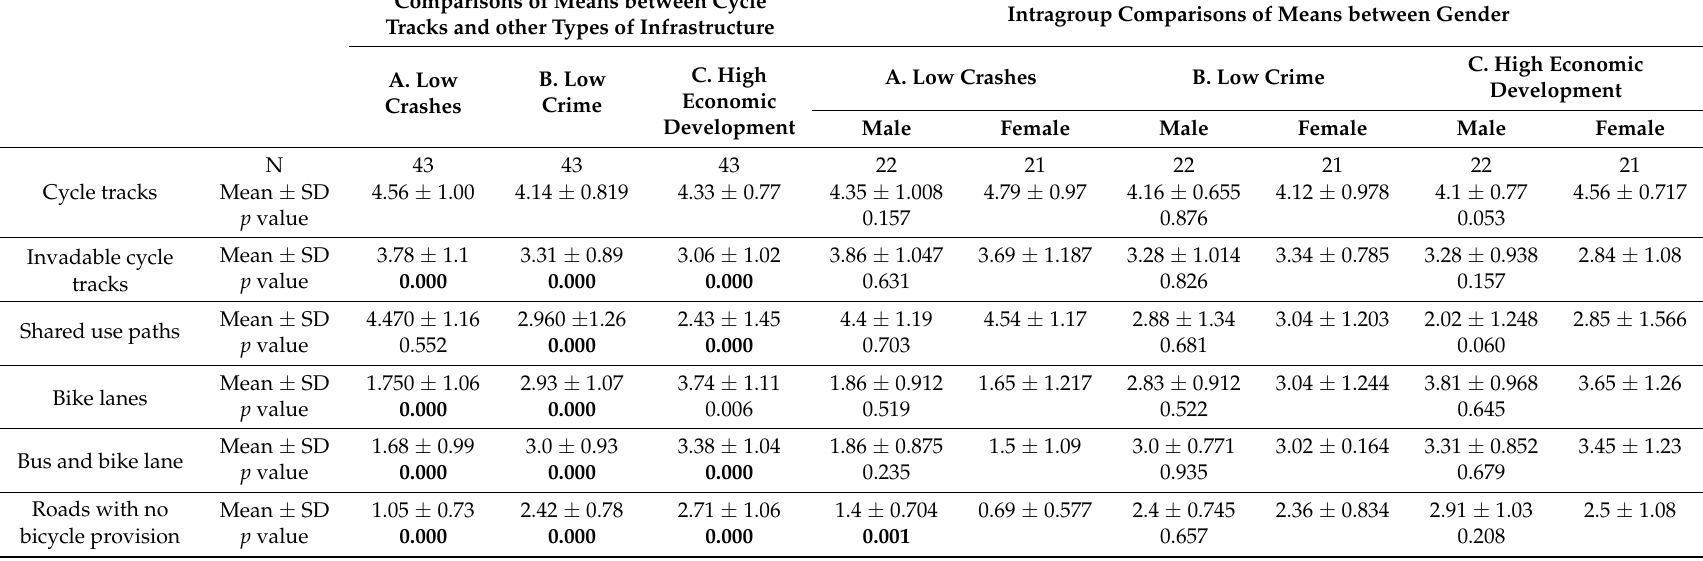
Table 2. Means given to the images, grouped by type of infrastructure on the core areas: Crashes, Crime, and Economic Development (Phase